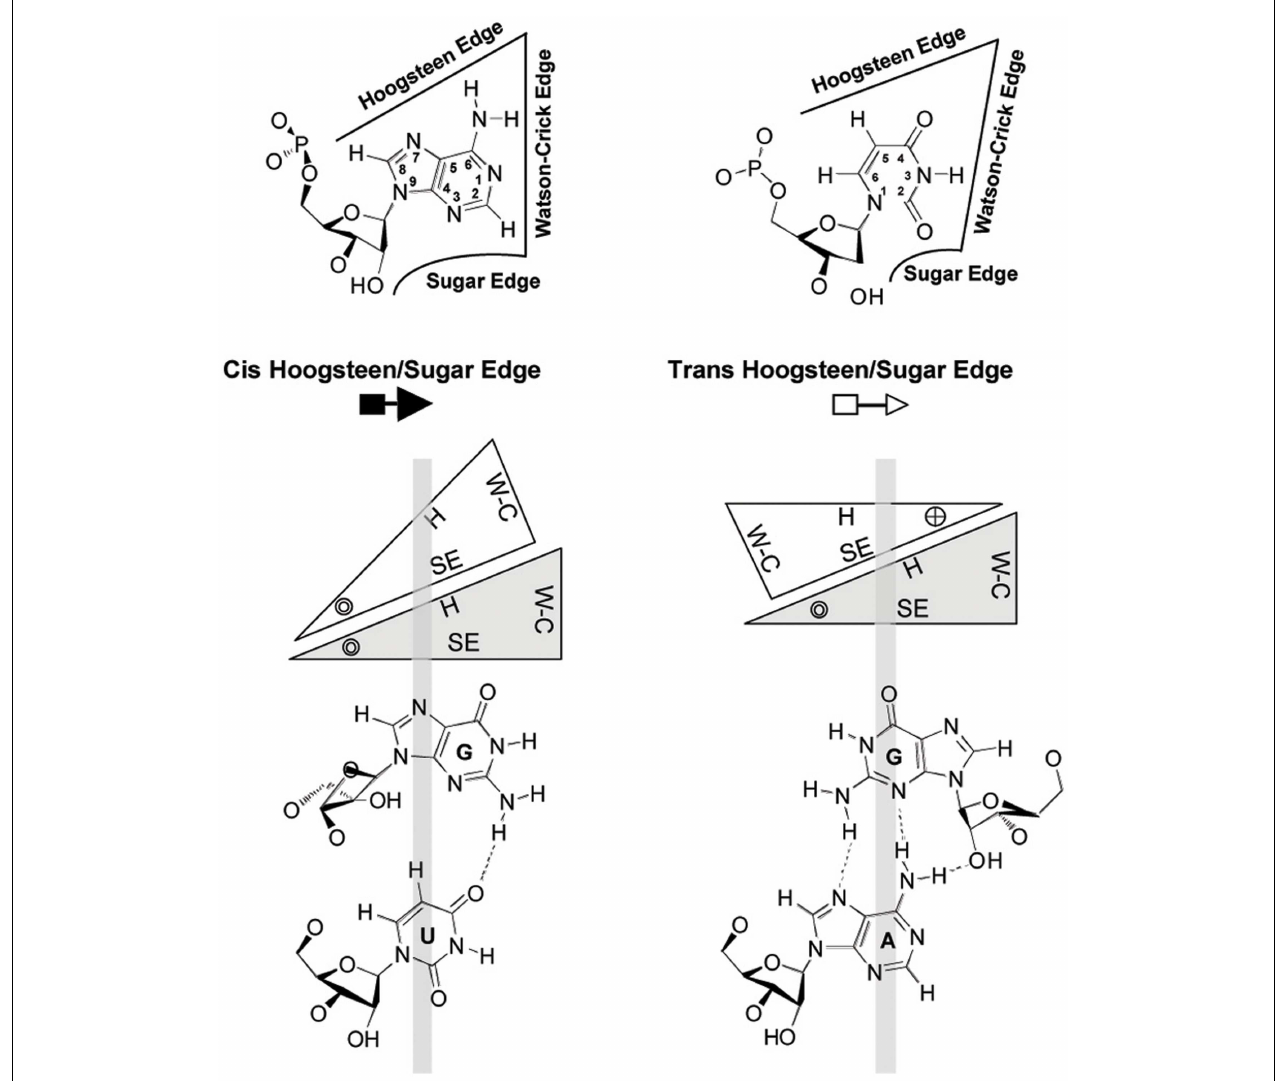
the sugar edge of the second base. In these base-pairs, theWatson–Crick edges of the interacting bases are available for further interactions – with other RNAs, proteins, or small molecules.The cross and circle in the triangle where the Hoogsteen and sugar edges meet indicate 5 (cid:48) → 3 (cid:48) and 3 (cid:48) → 5 (cid:48) orientations, respectively, of the sugar-phosphodiester backbones relative to the plane of the page.W–C,Watson–Crick edge; H, Hoogsteen edge; SE, sugar edge. Reproduced with permission from Zhong et al.